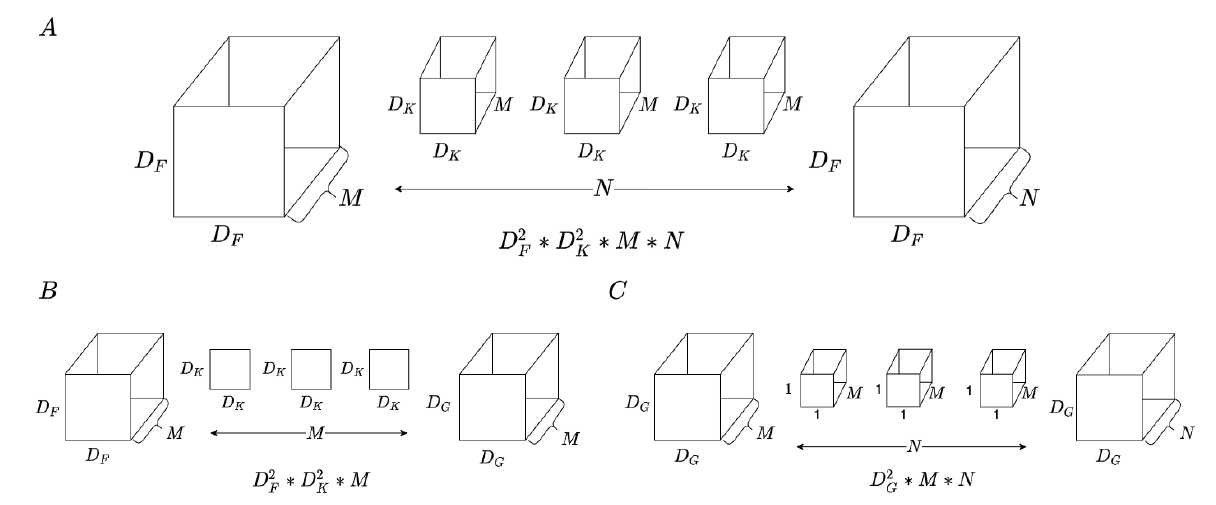
Figure 3. The depthwise separable convolution separated the standard convolution ( A ) into two parts: depthwise convolution in ( B ) and pointwise convolution in ( C ). The 1 × 1 convolution filters are called pointwise convolution in depthwise separable